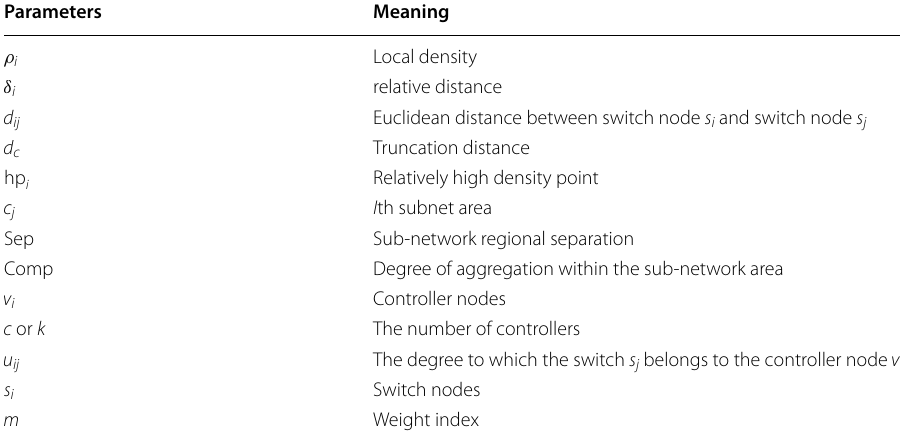
Table 1 List of